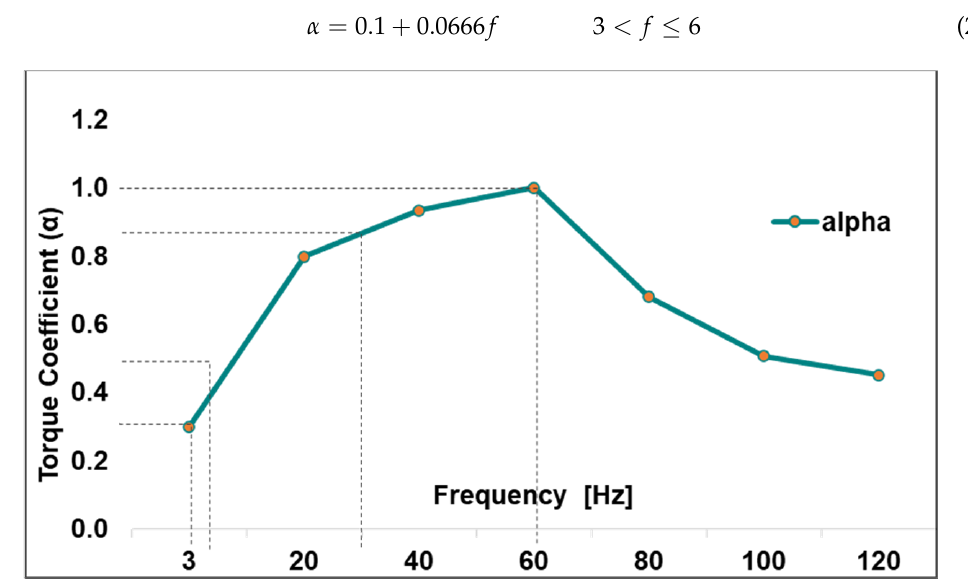
Figure 6. Torque coefficient curve of the V/F control induction motor used in this study. In the same way, the response of torque coefficient was observed to be steady and linear from 0.5 to 0.83 within the frequency range of 20–30 Hz: